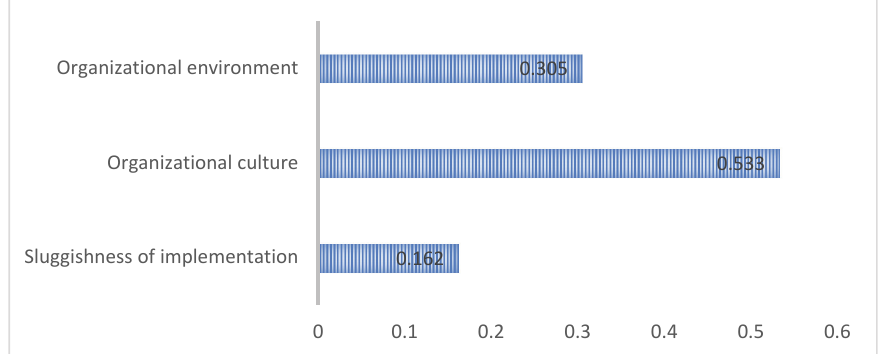
Fig. 4. The results of the implementation of AHP method for ranking main factors